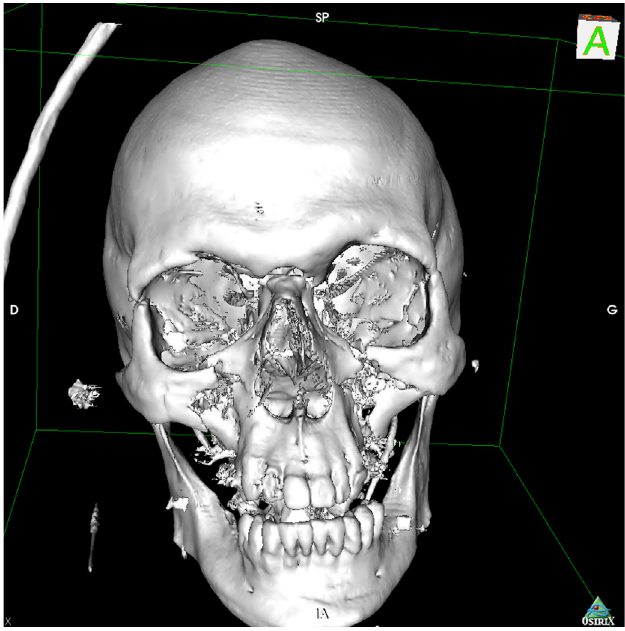
Fig. 1. Type-I, type-II, type-III LeFort fracture associated with a naso-orbito-ethmoid (NOE) frontal